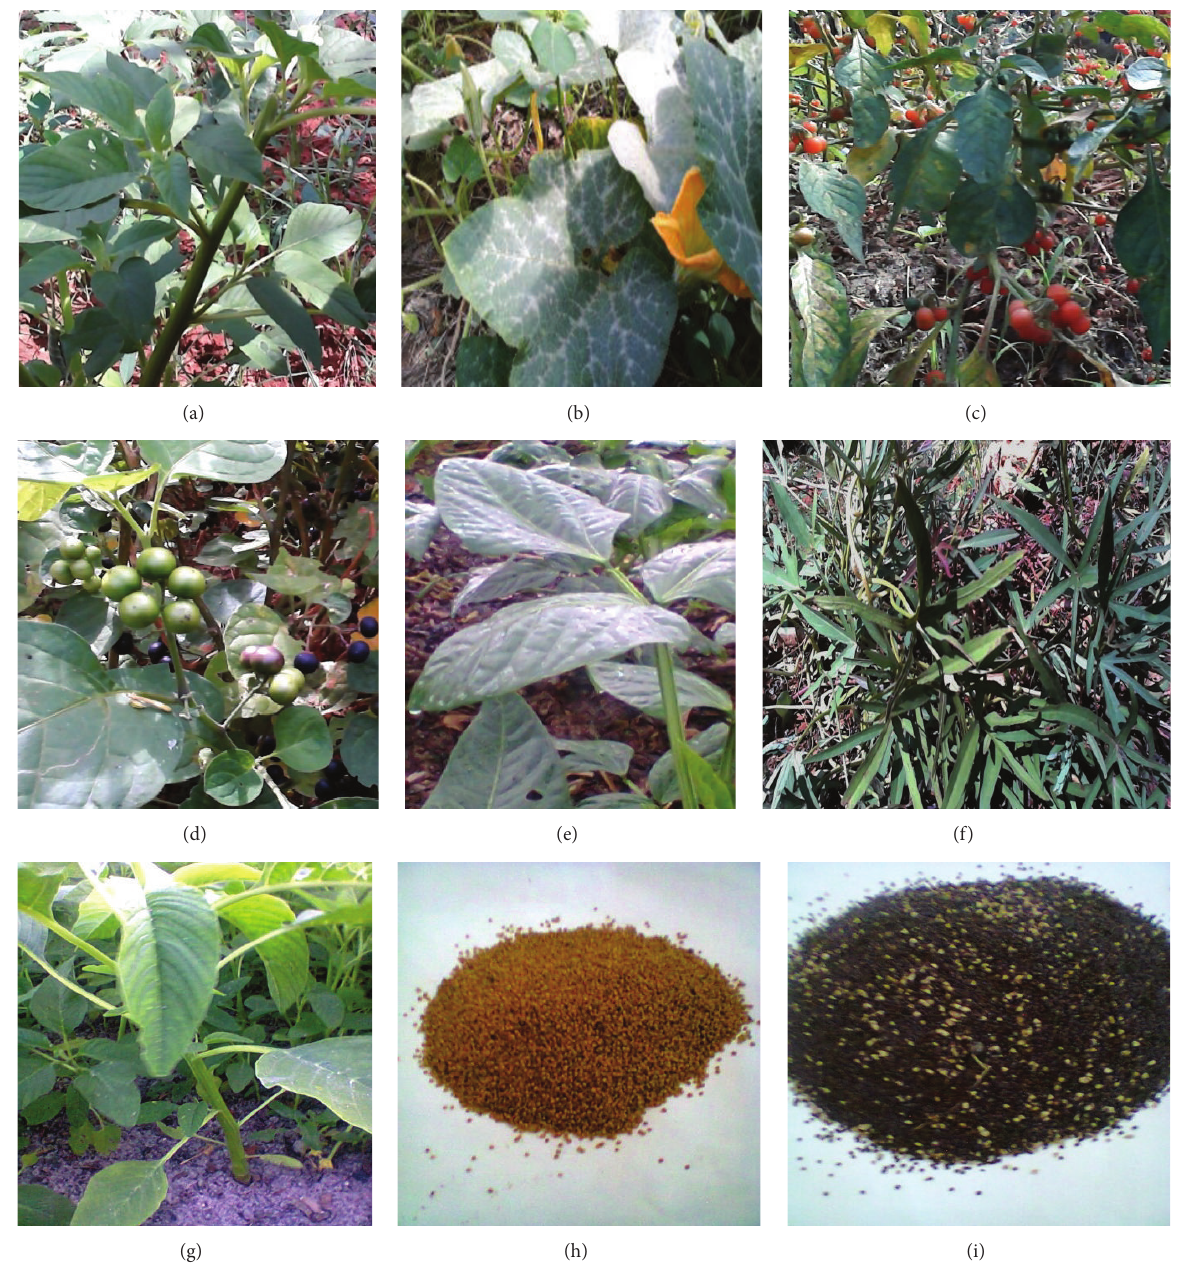
Figure 1: (a) Amaranthus hybridus , (b) Cucurbita maxima , (c) Solanum villosum , (d) Solanum scabrum , (e) Vigna unguiculata , (f) Ipomoea batatas , (g) Amaranthus sp., (h) Amaranthus hybridus seeds, and (i) Amaranthus sp. seeds.